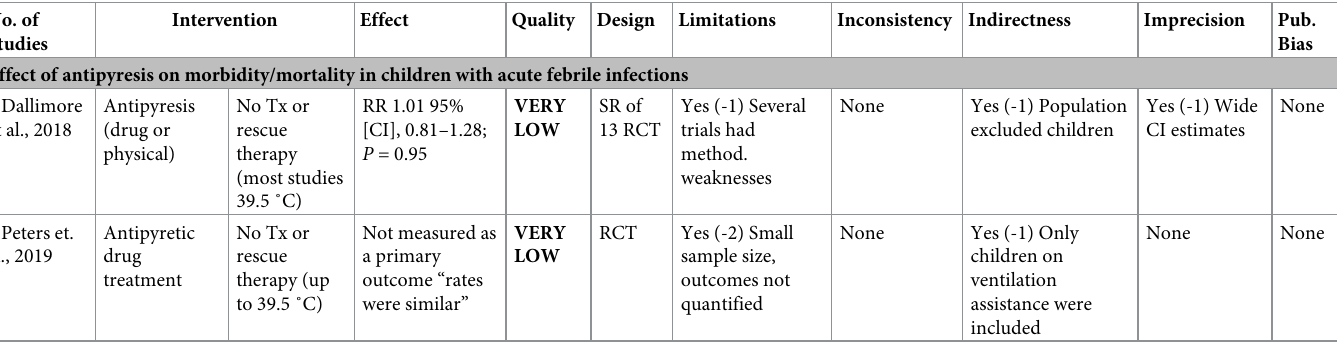
Table 2. GRADE analysis: Evidence tables. Intervention Imprecision Pub.